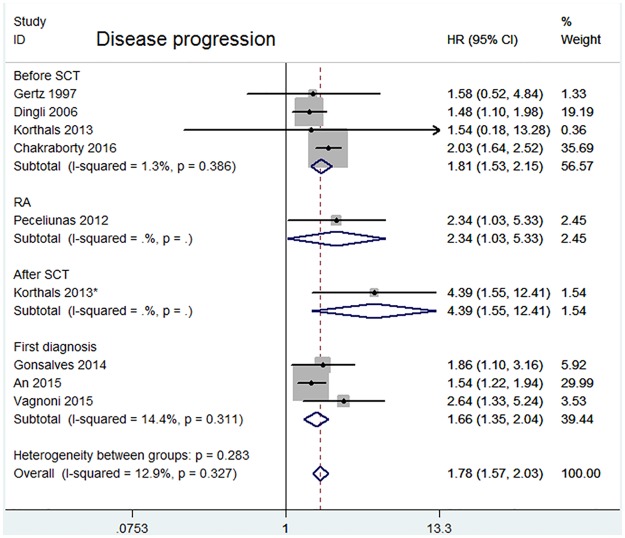
Forest plot of HRs and 95%CIs for disease progression.Subgroup analysis was according to different sampling time: four studies assessed CPCs before SCT; three studies assessed CPCs at first diagnosis. HR higher than 1 indicate that the presence of CPCs is associated with worse prognosis.